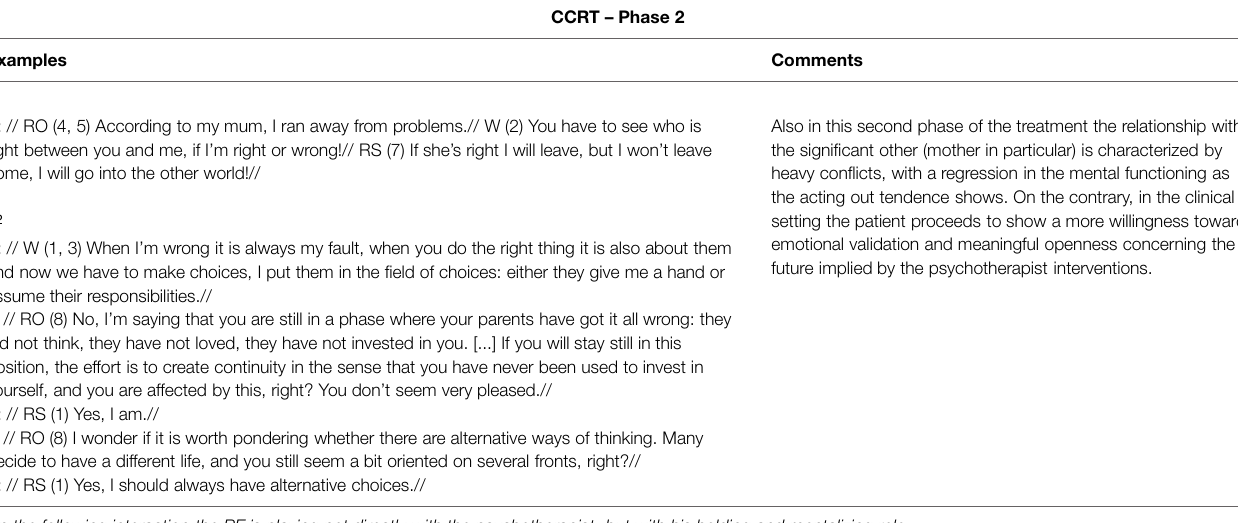
TABLE 2B | Mr. F’s CCRT – phase 2.